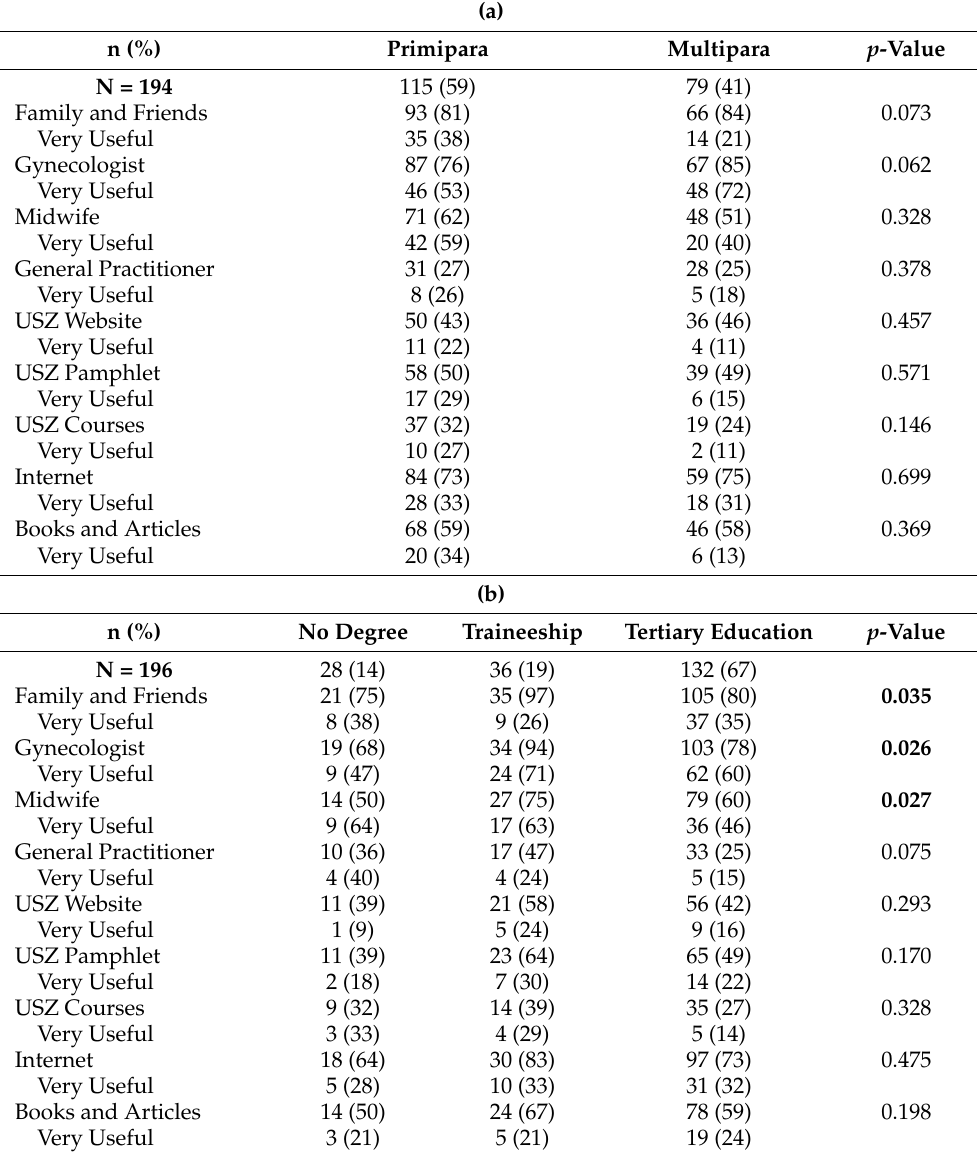
Table 3. (a) Consulted sources and their usefulness regarding birth, distinguished by number of births. (b) Consulted sources and their usefulness regarding birth, distinguished by educational level. Significant results are marked